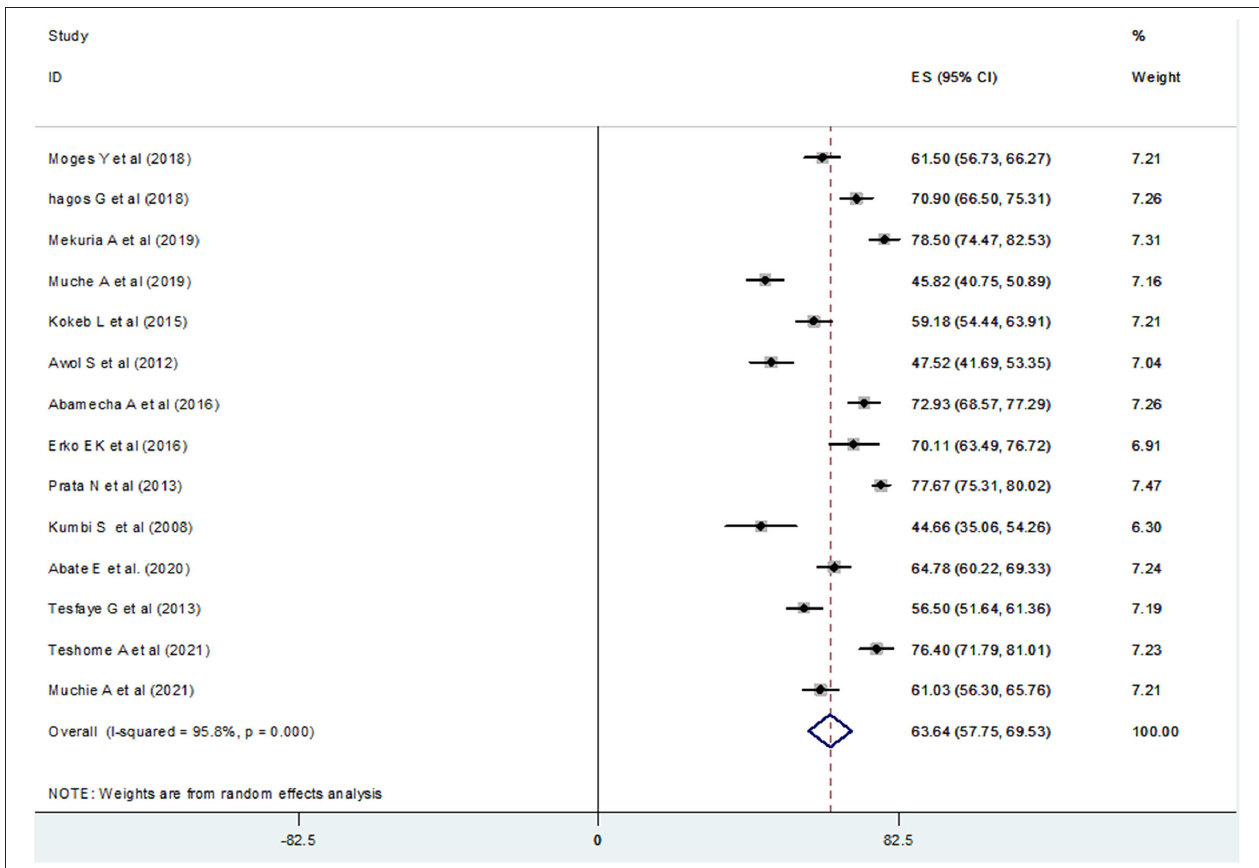
FIGURE 3 | Forest plot of the pooled prevalence of post-abortion contraceptive utilization of 14 studies in Ethiopia.